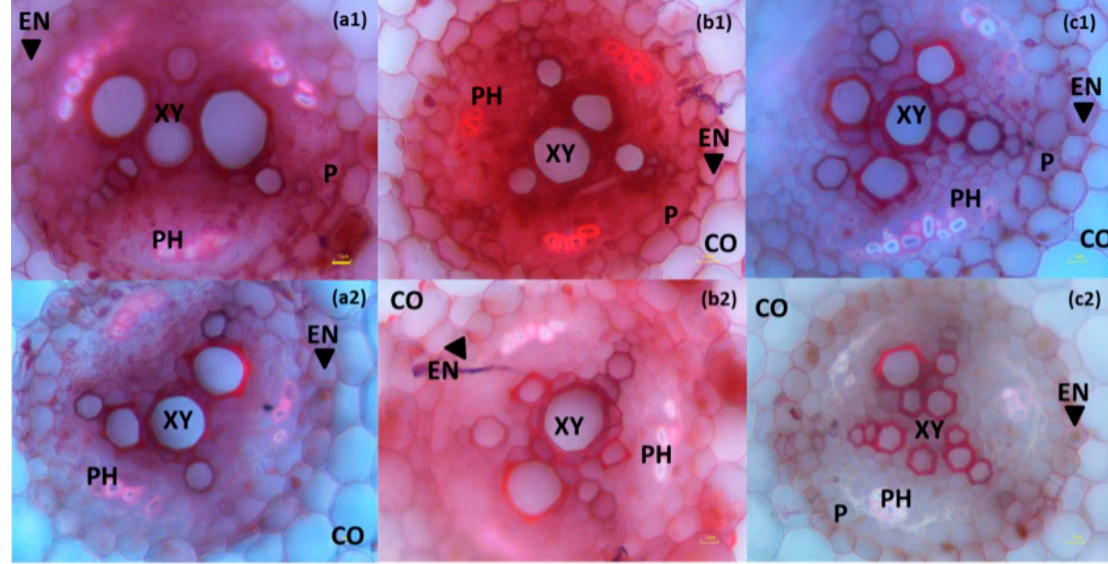
Figure 2. Freehand cross sections of first order lateral roots of peanut under well-irrigated conditions ( a1 , b1 and c1 ) and drought stress conditions ( a2 , b2 and c2 ) at 21, 28 and 35 DAE, respectively. CO, cortex; EN, endodermis; P, pericycle; PH, phloem; XY, xylem; Scale bar = 10 µm; 40×.